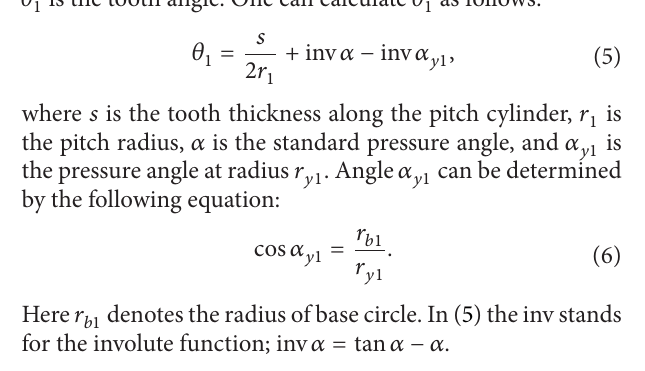
Figure2:Aconceptualsketchforthemanufactureofcrownedtooth surfaces.